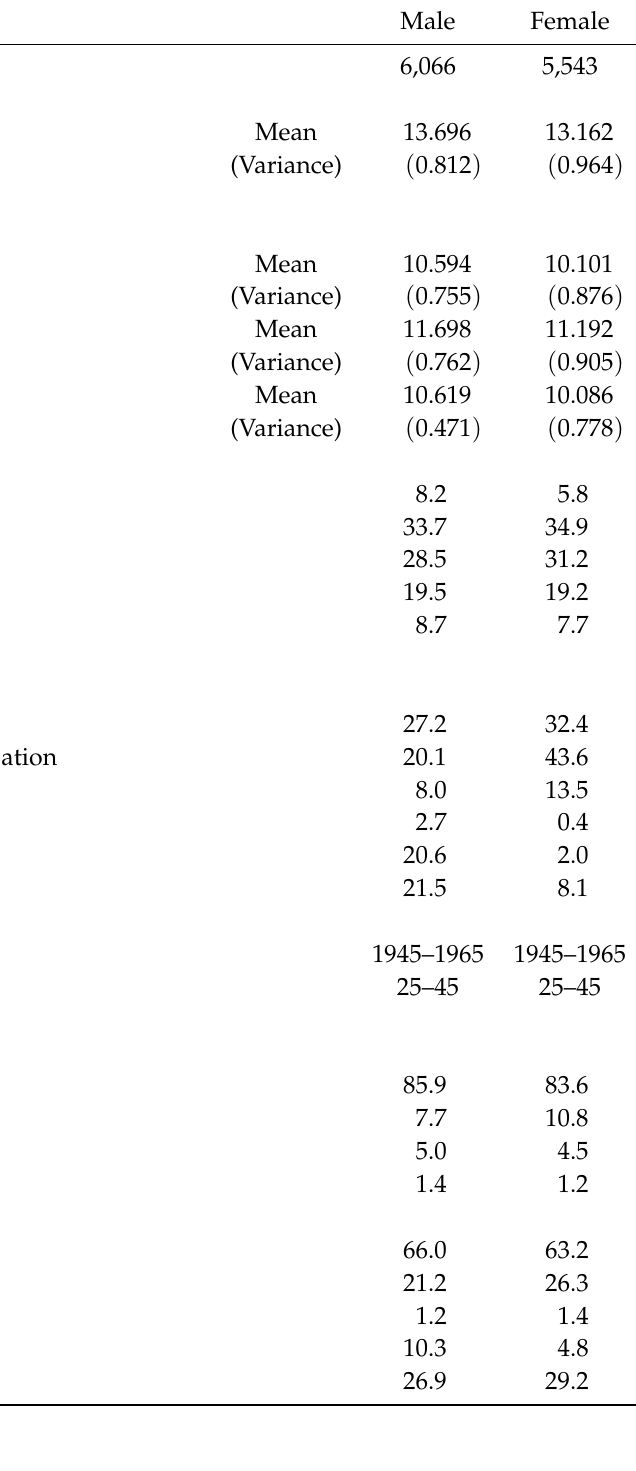
Table 1: Descriptive